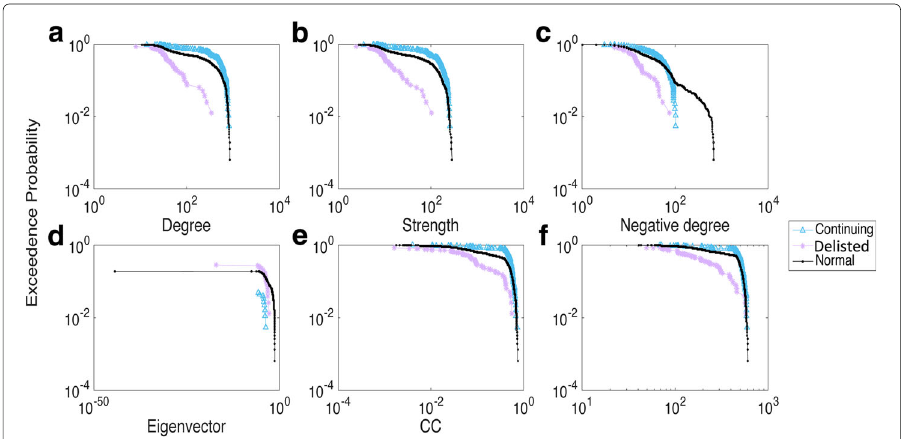
Fig. 9 Distribution of the six network measures in 2016-2017. a Degree; b Stength; c Negative degree; d Eigenvector; e CC; f Ave. Neigh.